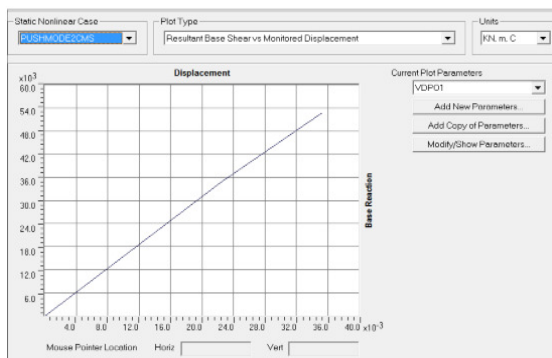
Fig. 10. Base shear vs. displacement in the longitudinal direction